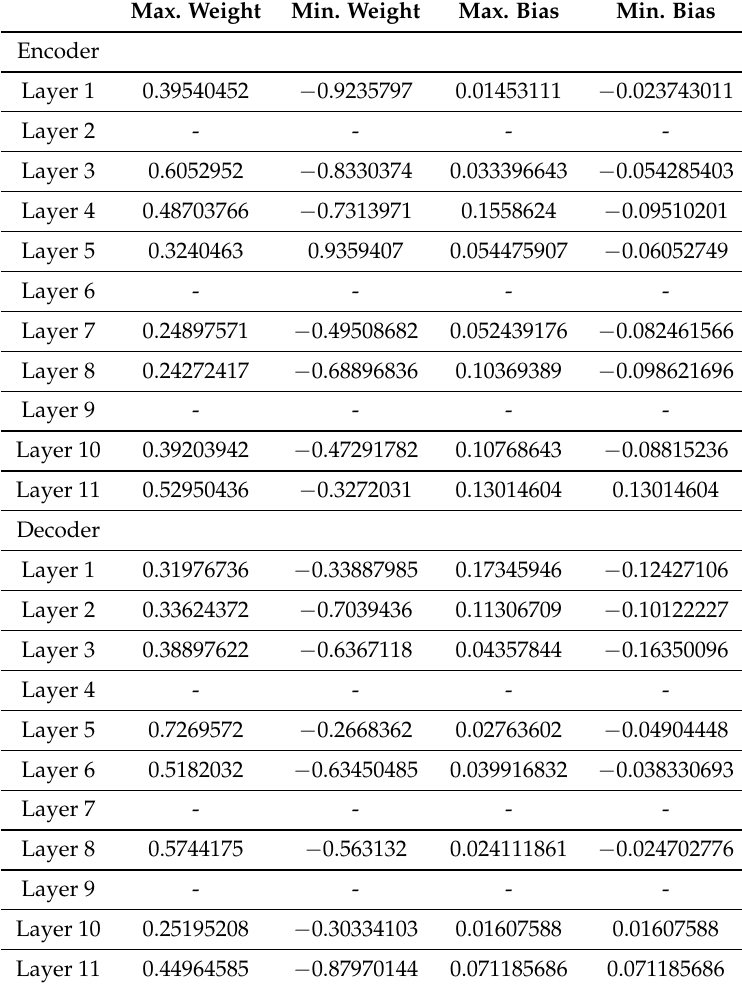
Table 5. The range of weight and bias for the proposed network model.